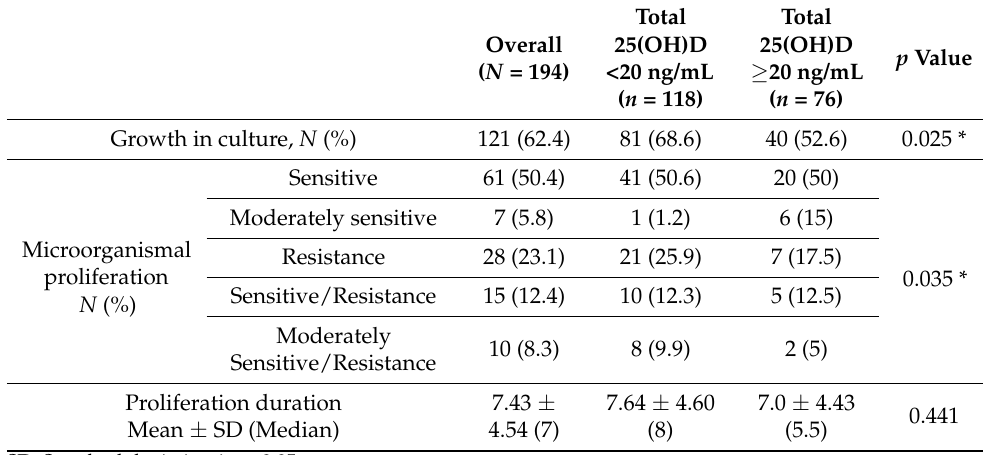
Table 6. Comparison of the microbiological findings of COVID-19 patients according to the vitamin D status.